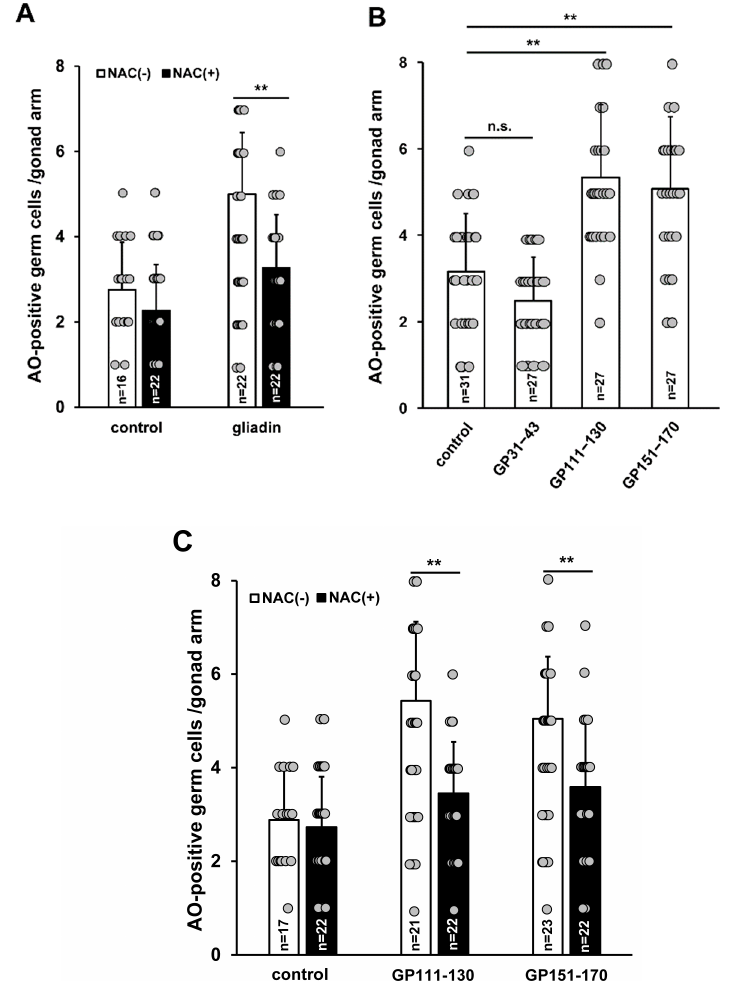
Figure 10. E ff ect of N-acetyl-L-cysteine (NAC) treatment on germ cell apoptosis triggered by intake of gliadin or synthetic gliadin peptides in adult wild-type N2 C. elegans worms. ( A ) Average numbers of acridine orange (AO)-positive germ cells per gonad arm in gliadin-treated wild-type N2 worms fed with or without NAC. ( B ) Average numbers of AO-positive germ cells per gonad arm in wild-type N2 after treatment with synthetic gliadin peptides (GP31–43, GP111–130, or GP151–170). ( C ) Average numbers of AO-positive germ cells per gonad arm in synthetic gliadin peptide (GP111–130 and GP151–170)-treated wild-type N2 worms fed with or without NAC. n.s., not significant. ** p < 0.005 (Student’s t -test).